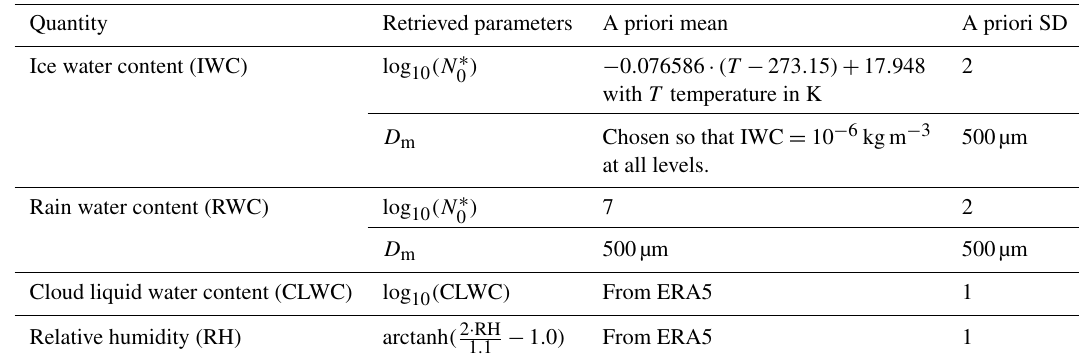
) is taken from 0